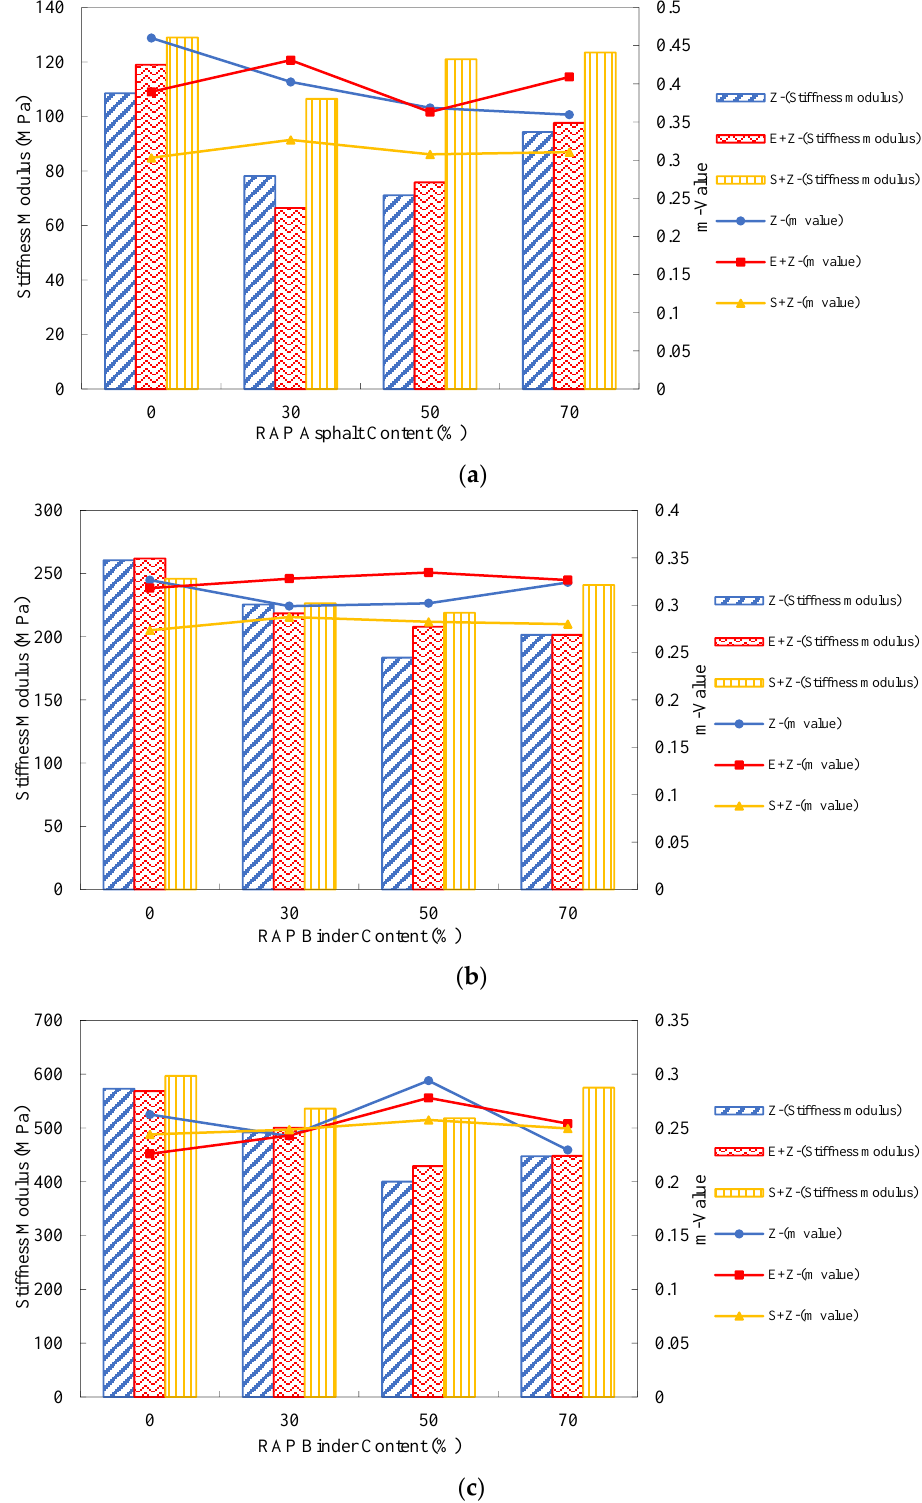
Figure 12. Creep stiffness and m value test results of the warm-mix recycled binders at different RAP binder contents and testing temperatures under the long-term aged condition: ( a ) − 12 °C; ( b ) − 18 °C; ( c ) − 24 °C. Table 11. Percentage increases of S a and m-value with the RAP binder content under the long-term aged condition.